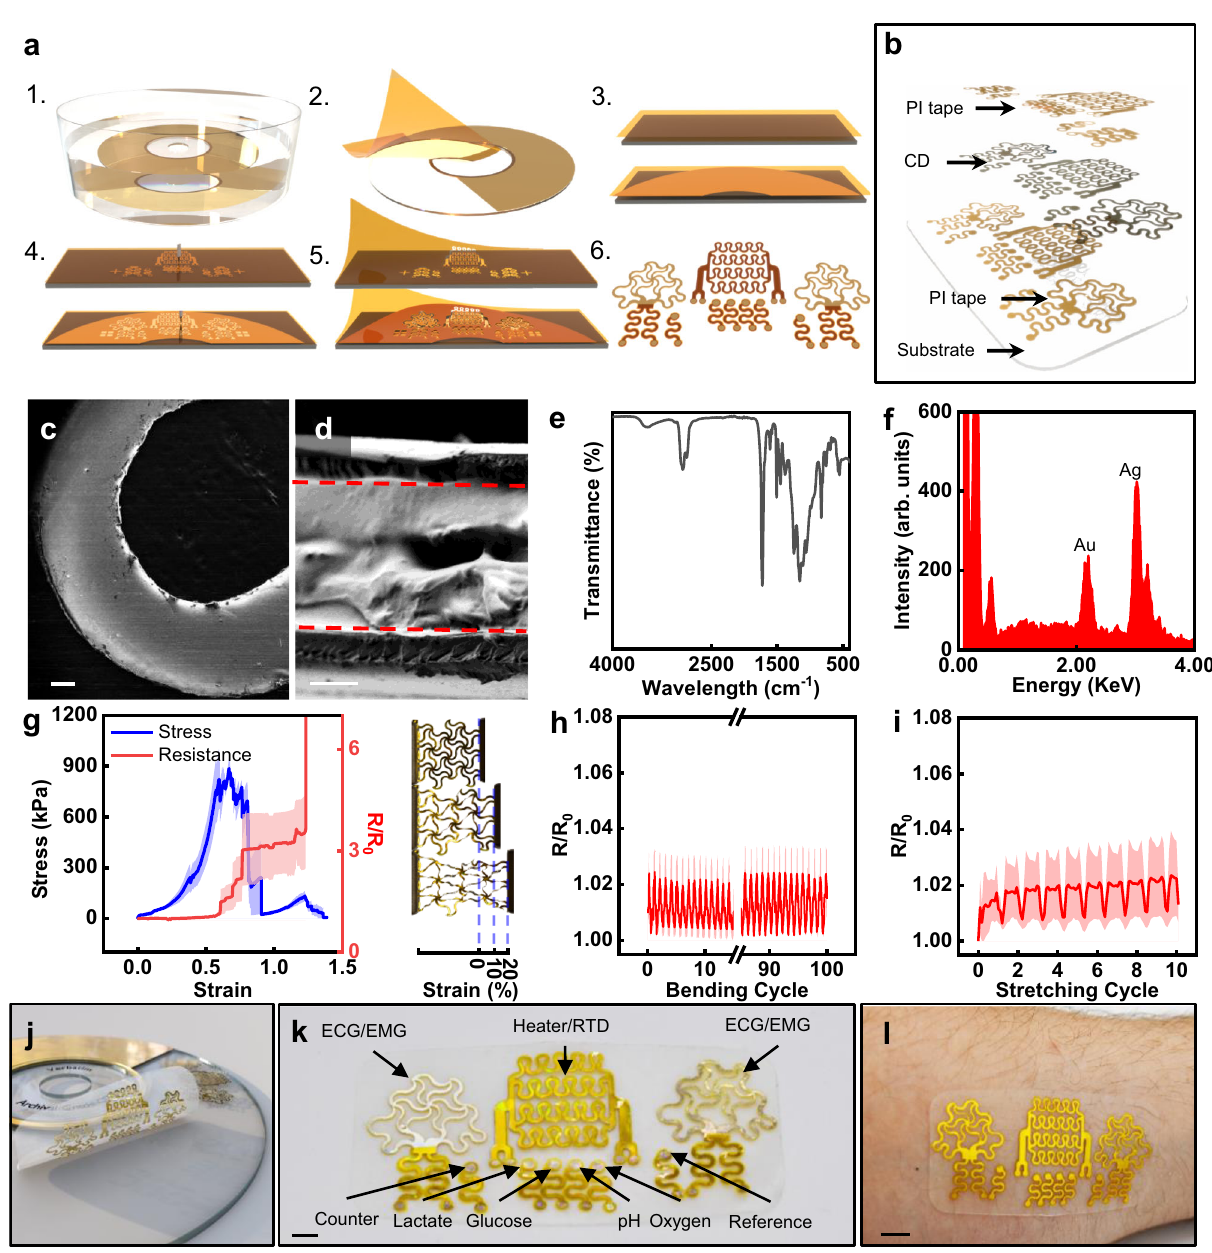
Fig. 1 Upcycling CDs into stretchable electronics. a Schematic of the upcycling process. (1) soak in acetone; (2) harvest metal layer with PI tape; (3) (bottom) laminate CD on tattoo paper; (top) PI tape laminated on water-soluble tape; (4) pattern with mechanical cutter; (5) remove excess and laminate insulation layer; (6) UCDEs. b Cross-sectional view of the UCDE. SEM image of c the CD metal layer after patterning (scale bar, 200 µ m) and d cross- section of the UCDE (PI-metal-PI)(scale bar, 20 µ m). e FTIR of the metal layer (PMMA side) after processing in acetone, HCl, and HNO 3 . f Surface characterization with EDS analysis of the CD (metal layer) after soaking in acetone. g Mechanical properties as a function of electrical performance, average and standard error of means ( n = 3) of stress vs. strain (blue) and resistance vs. strain (red). Images of lattice patterned UCDE during tensile testing. Toe region (15 mm length), heel region (19 mm length, 27% strain), and linear region (22.5 mm length, 50% strain). Electrical performance, average and standard error of means ( n = 3) resistance properties as a function of h cyclic bending and i cyclic stretching. j Representative image of UCDE device. k Components of the UCDE device (scale bar, 4 mm). l Image of the UCDE device laminated on the skin (scale bar, 1 Fig. 1a4. Patterns are easily loaded onto the Cricut Design Space layer, thus yielding the upcycled CD electronics (UCDEs) software by importing AutoCAD drawings, and the PI-metal (Fig. 1a6, b). Images of the full process are shown in Supple- layer is carved by the cutting machine (Cricut Maker, USA). mentary Fig. 7. After processing, the UCDEs demonstrated a Subsequently, insulation layers can be patterned through a similar base, four-probe resistance of around 0.03 Ω /cm 2 . The mechanical cutter produced very precise cuts, and the PI tape process by adhering the PI tape to water-soluble tape (Fig. 1a3 – 4). fully insulates the metal layer (Fig. 1c and Supplementary Fig. 8a, b). After processing, the excess material from the metal and insula- The overall thickness of the harvested metal layer from the CD was tion layers was removed (Fig. 1a5). The alignment marks allowed 30.35 ± 1.92 µm, consisting of a protective, polymethylmethacrylate the insulation layer to be aligned and laminated onto the metal